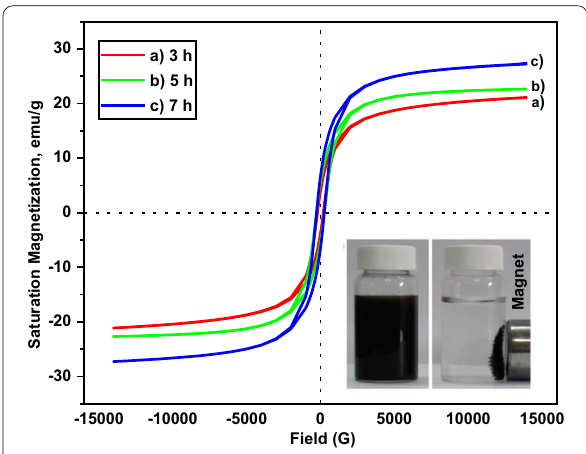
Fig. 4 M-H hysteresis graph of samples at different milling times a 3 h, b 5 h and c 7 h